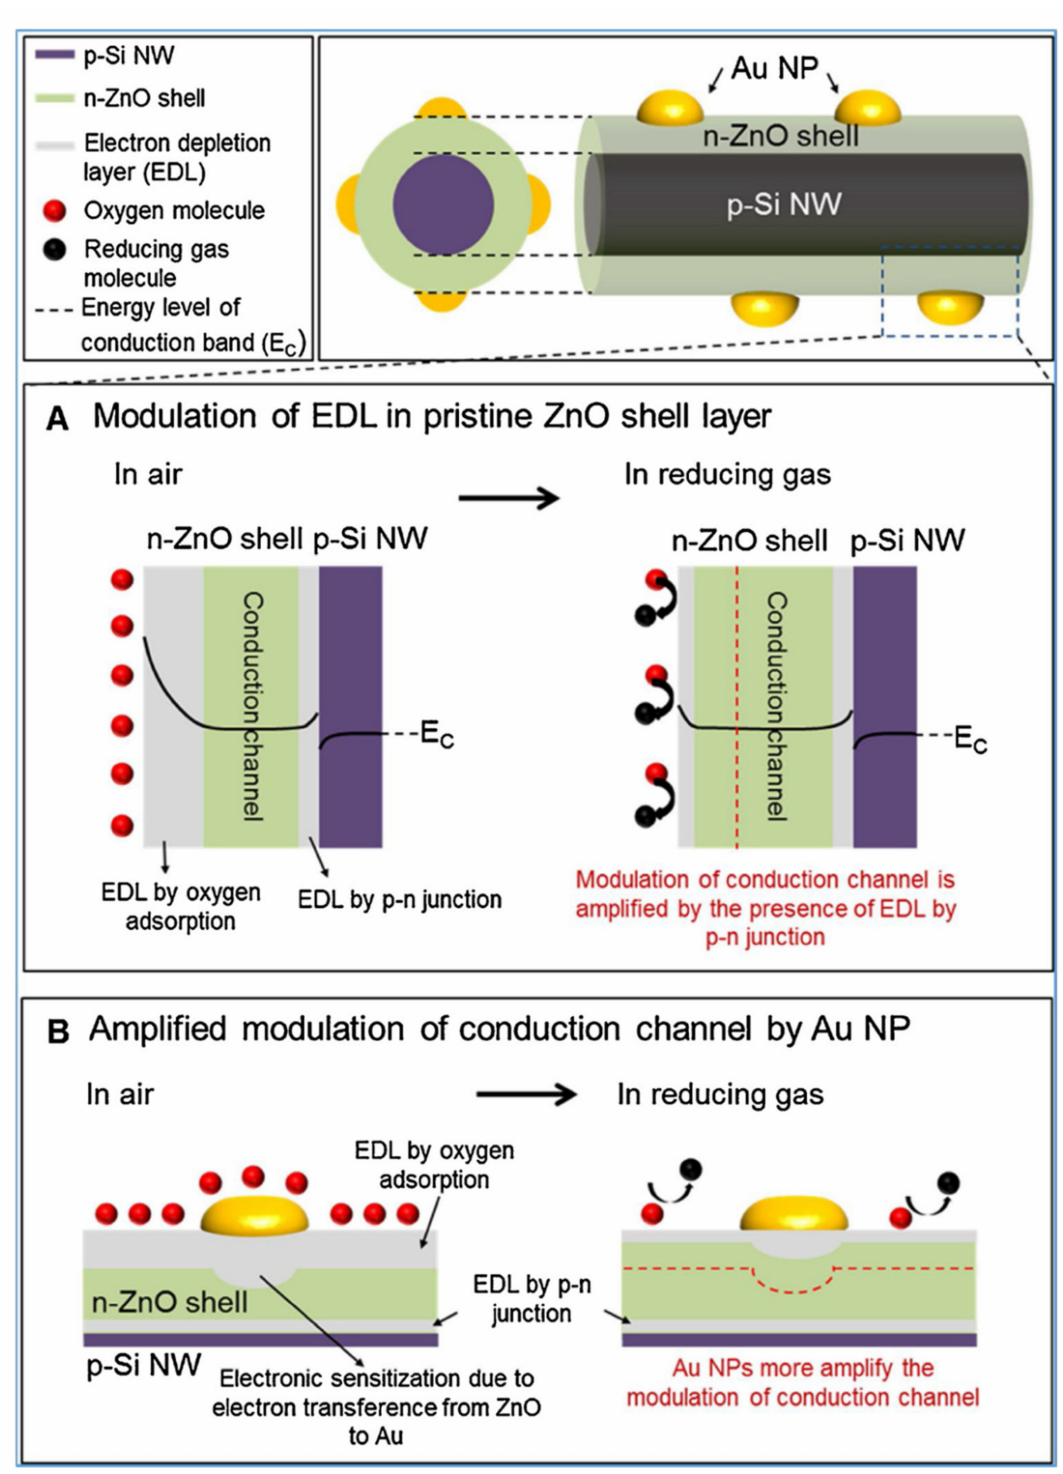
Figure 30. Sensing mechanism in the Au-functionalized SiNWs / ZnO core-shell gas sensor, ( a ) Formation of the depletion layers in the pristine SiNWs / ZnO core-shell layer and ( b ) Expansion of the electron depletion layer in the presence of Au. Reproduced from [174], with permission from Elsevier,